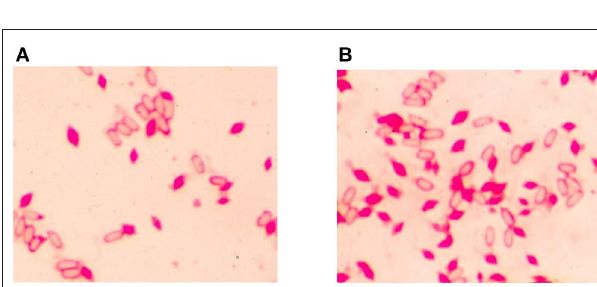
FIGURE 3 | Microscope of B. thuringiensis HD-1 and HD-1- 1 hmgA under oil lens (100 × ). (A) Crystal observation of strain HD-1. (B) Crystal observation of mutant HD-1- 1 hmgA . Both strains have no distinct difference in spore and crystal formation.